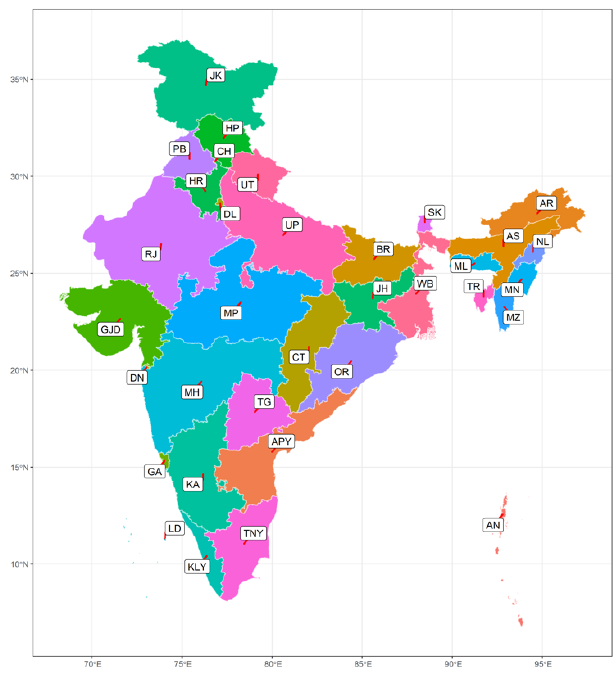
Figure A1. IDEEA spatial division, 34-region version.